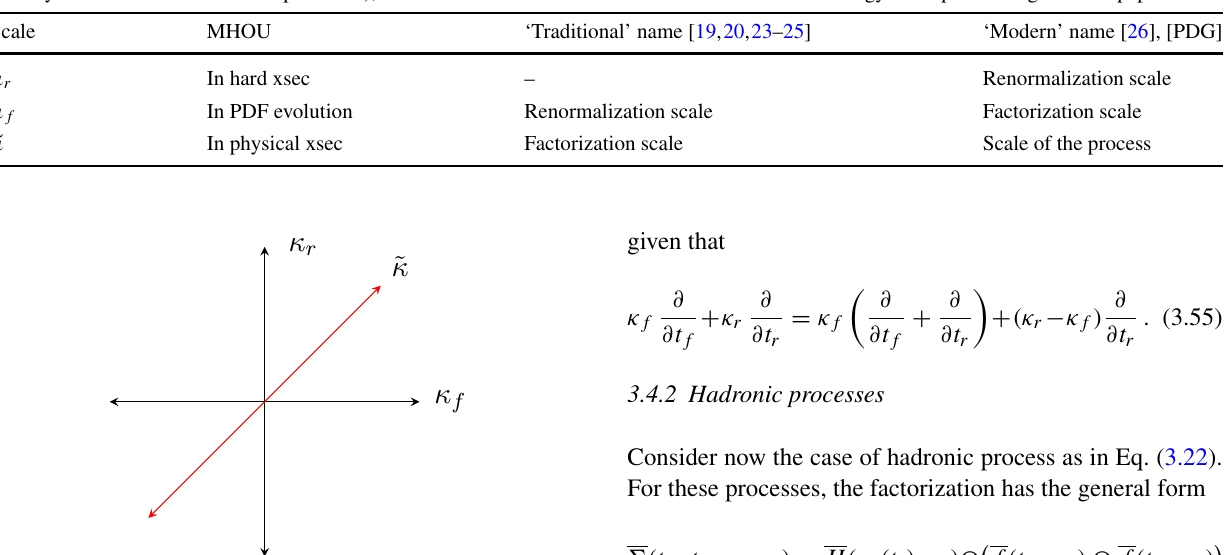
Table 1 Nomenclatures for the different scale variations used in some of the earlier papers (mainly in the context of DIS), and in more recent work (mainly in the context of hadronic processes), as discussed in detail in the text. The ‘modern’ terminology is adopted throughout this paper